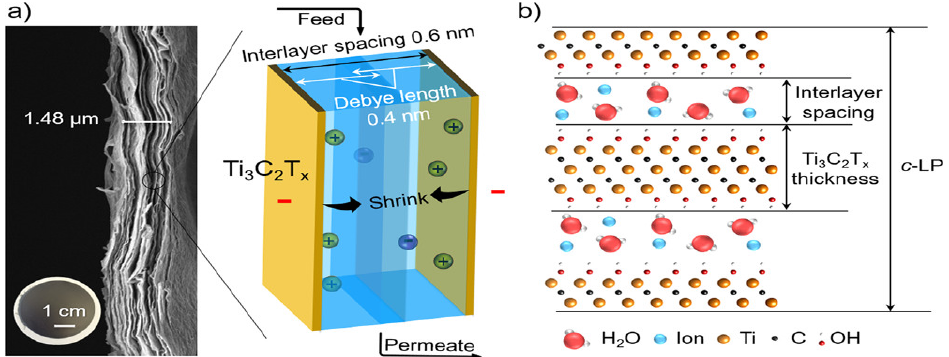
Figure 10. ( a ) Cross-section scanning electron microscopy image of laminar Ti 3 C 2 T x MXene ERM and a diagram illustrating the behavior of ions within the electrical double layers of laminar Ti 3 C 2 T x Mxene ERM when a negative voltage is applied. ( b ) Molecular model showing water molecules and ions within layers of laminar Ti 3 C 2 T x Mxene ERM. Reproduced with permission from [26] .